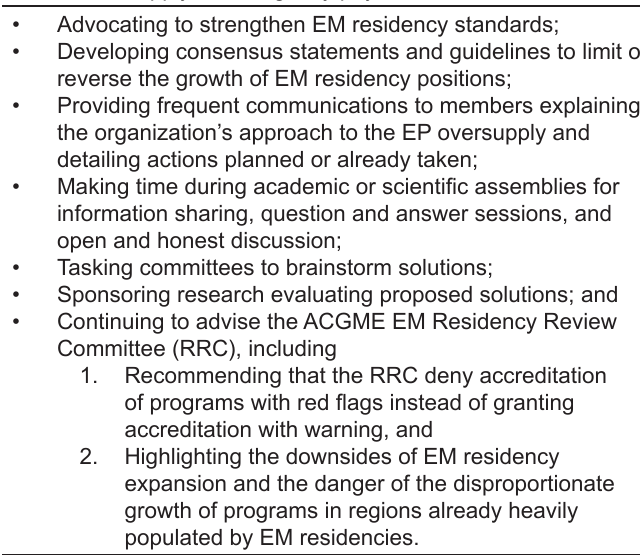
Table 3. Strategies professional organizations could employ